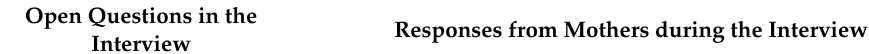
Table 1. Questions and responses during the interview with ten families